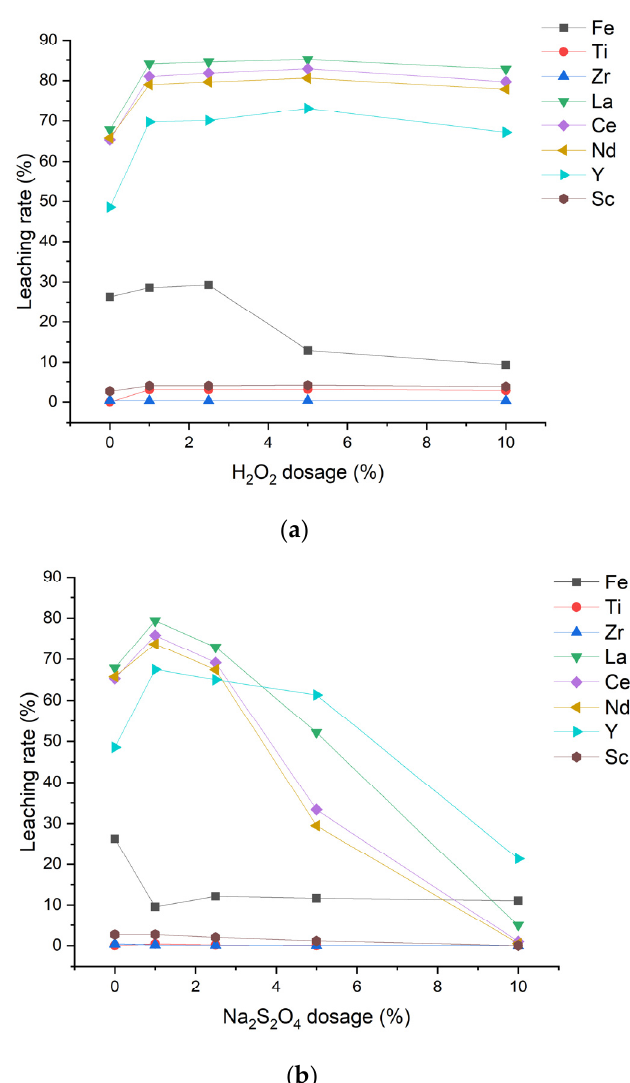
Figure 7. Leaching rate of iron, zirconium, lanthanum, cerium, neodymium, yttrium, and scandium varying the percentage of ( a ) hydrogen peroxide (H 2 O 2 ) and ( b ) sodium dithionite (Na 2 S 2 O 4 ). Experimental conditions: 100 mL of H 2 SO 4 2.0 mol/L; solid-liquid ratio = 1/10; T = 25 °C; t = 8 h; stirring speed = 200 rpm.